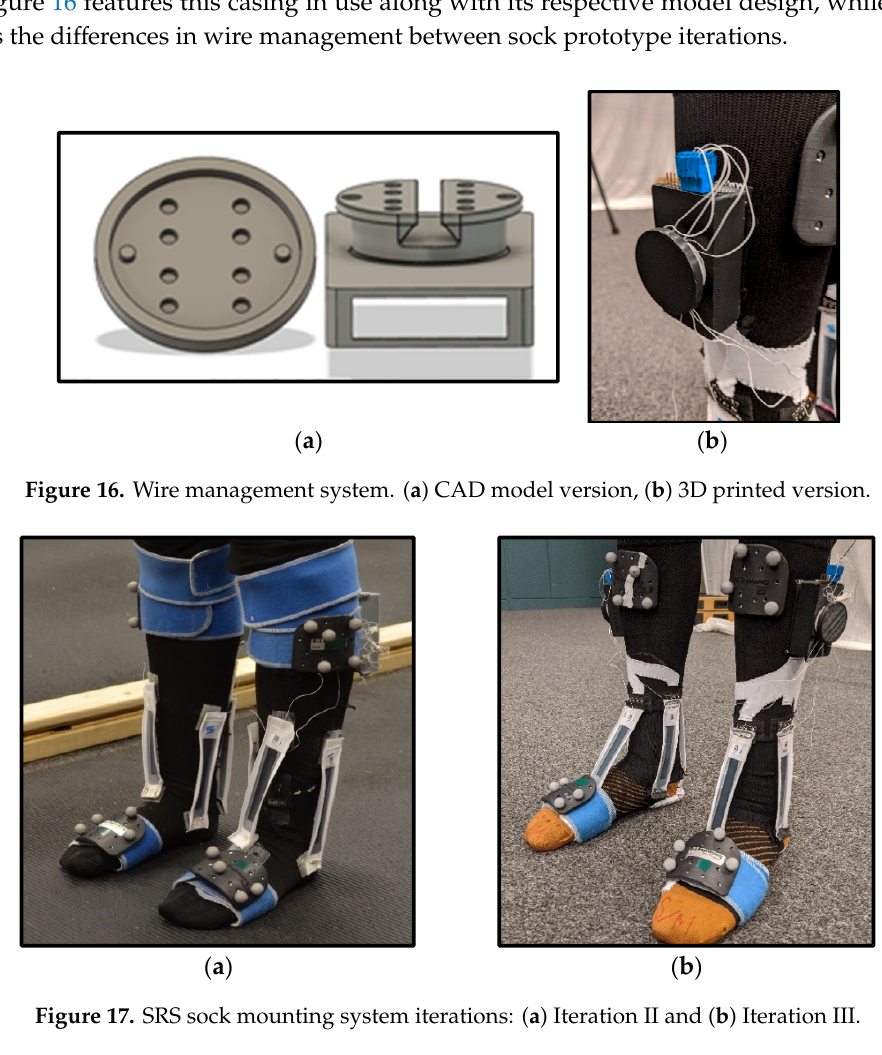
Figure 15. Snap case design for ease of access to the sensor.